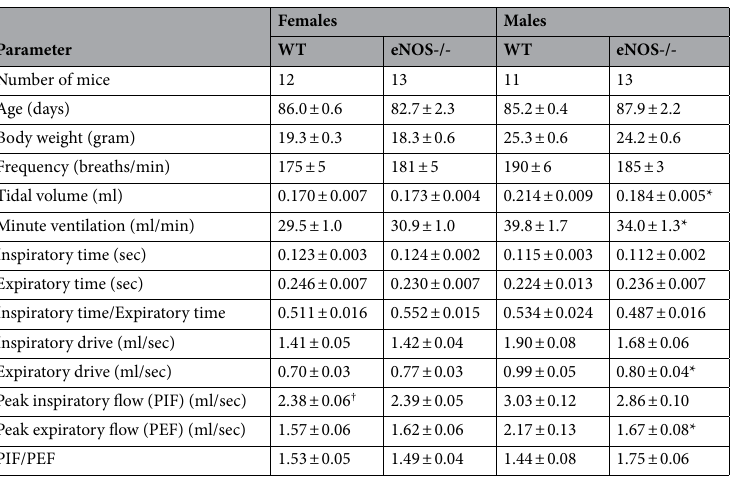
Table 2. Resting parameters in female and male wild-type and endothelial nitric oxide synthase knock-out mice. The data are presented as mean ± SEM. WT, wild-type C57BL6 mice. eNOS-/-, endothelial nitric oxide synthase knock-out mice. * P < 0.05, eNOS-/- versus WT for male and female mice.